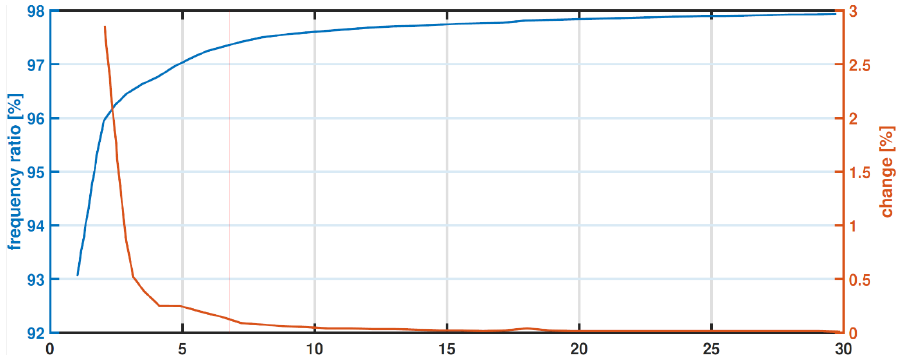
Figure 10. Representation of the mean frequency components in the entire spectrum per Hz in percent (blue) and the respective change in frequency per Hz (orange). The red line marks the limit at which the change was less than 0.1%/Hz.